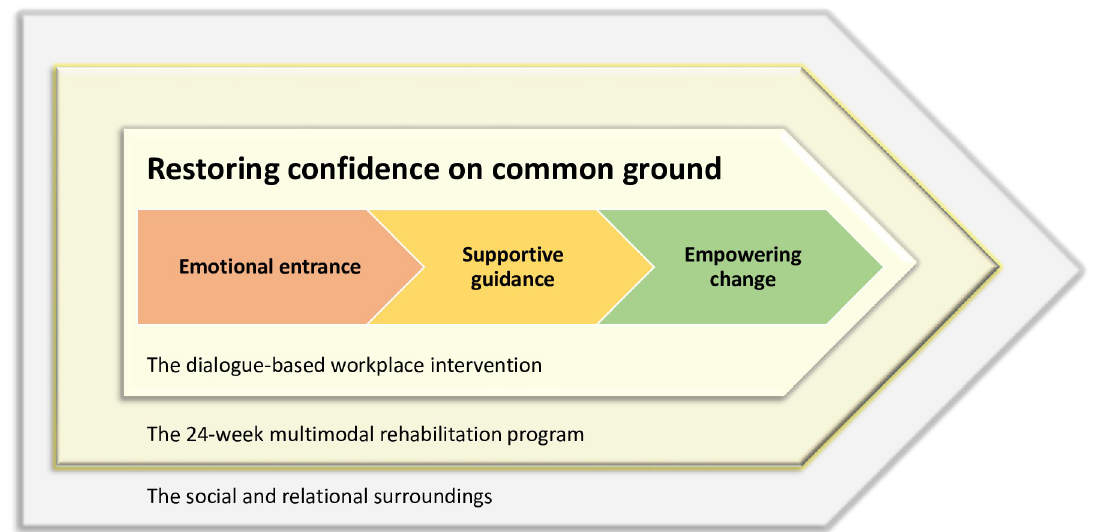
Fig 2. Illustrated theoretical model with its health promoting process directed towards a sustainable return to